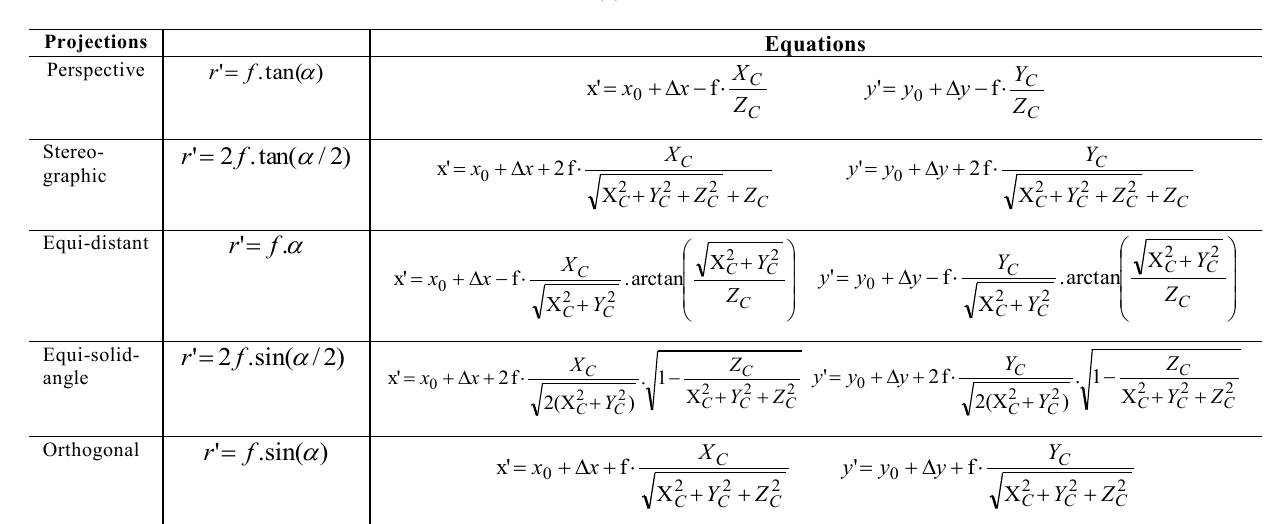
Table 1 - Mathematical models for the calibration of fisheye lens camera (Adapted from Ray (2002); Abraham and Förstner (2005)).